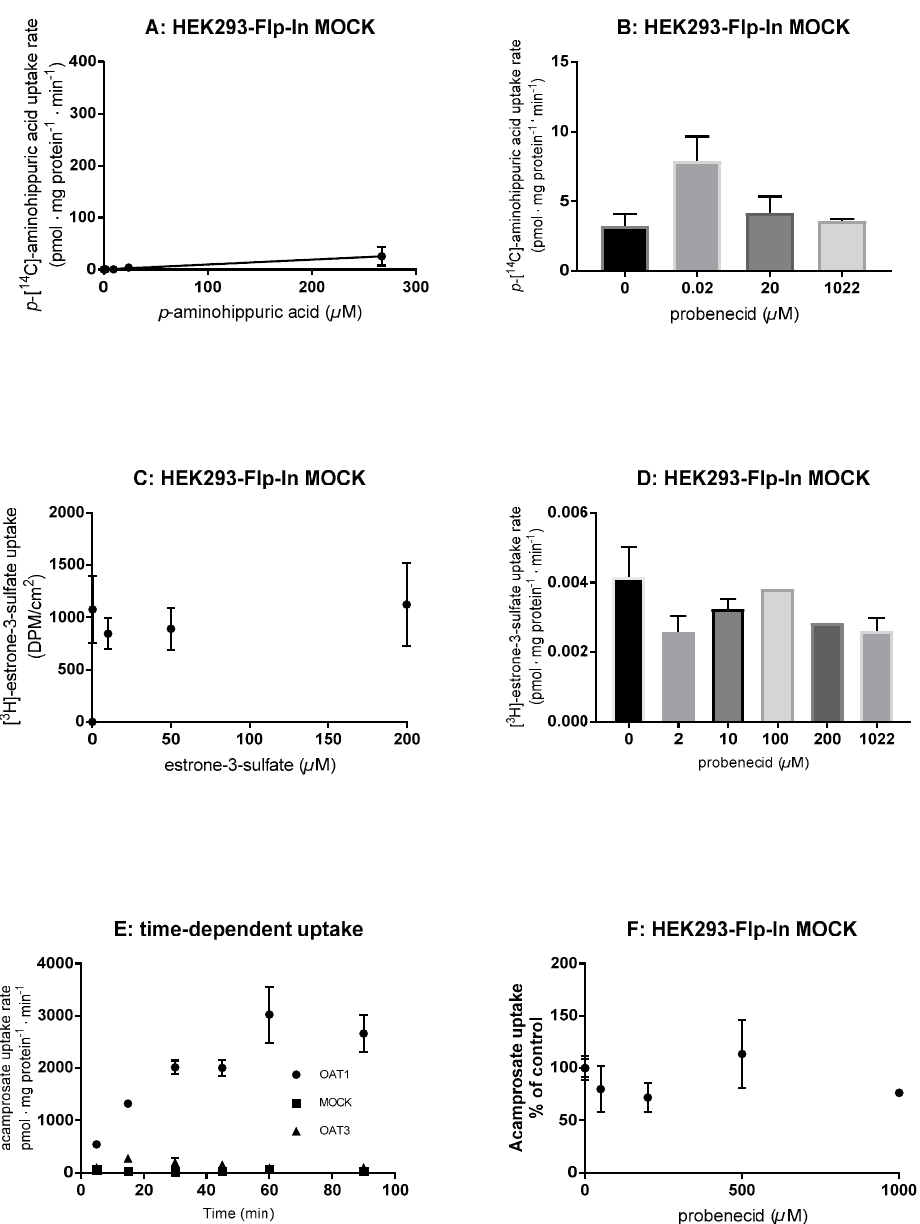
Figure A1. ( A ) The uptake rate of 0–277 µ M of PAH using 0.02–9.5 µ M [ 14 C]-PAH in HEK293-Flp-In Mock cells. Each data point represents the mean ± SEM of replicates in three cell passages obtained at Lab. 1. ( B) E ff ect of 0.02–1022 µ M probenecid on the uptake rate of 9.5 µ M [ 14 C]-PAH in HEK293-Flp-In Mock cells. Each data point represents the mean ± SEM of replicates in three cell passages obtained at Lab. 1. ( C) The uptake (DPM / cm 2 ) 0.02 µ M [ 3 H]-E3S in HEK293-Flp-In Mock cells in the presence of 0–200 µ M E3S. Each data point represents the mean ± SEM of replicates in three cell passages obtained at Lab. 2. ( D ) E ff ect of 0.02–1022 µ M probenecid on the uptake rate of 0.02 µ M [ 3 H]-E3S in HEK293-Flp-In Mock cells. Each data point represents the mean ± SEM of replicates in three cell passages obtained at Lab. 2. ( E ) Time-dependent uptake of acamprosate in HEK293-Flp-In OAT1, Mock or OAT3 expressing cells. Each data point represents the mean ± SD of three replicates in one cell passages obtained at Lab. 1. ( F ) Acamprosate uptake (% of control) with increasing concentrations of probenecid (0.02–1000 µ M). The uptake of 200 µ M acamprosate in HEK293-Flp-In Mock cells was measured in bu ff er pH 7.4. Each data point represents the mean ± SEM obtained in three cell passages obtained at Lab.